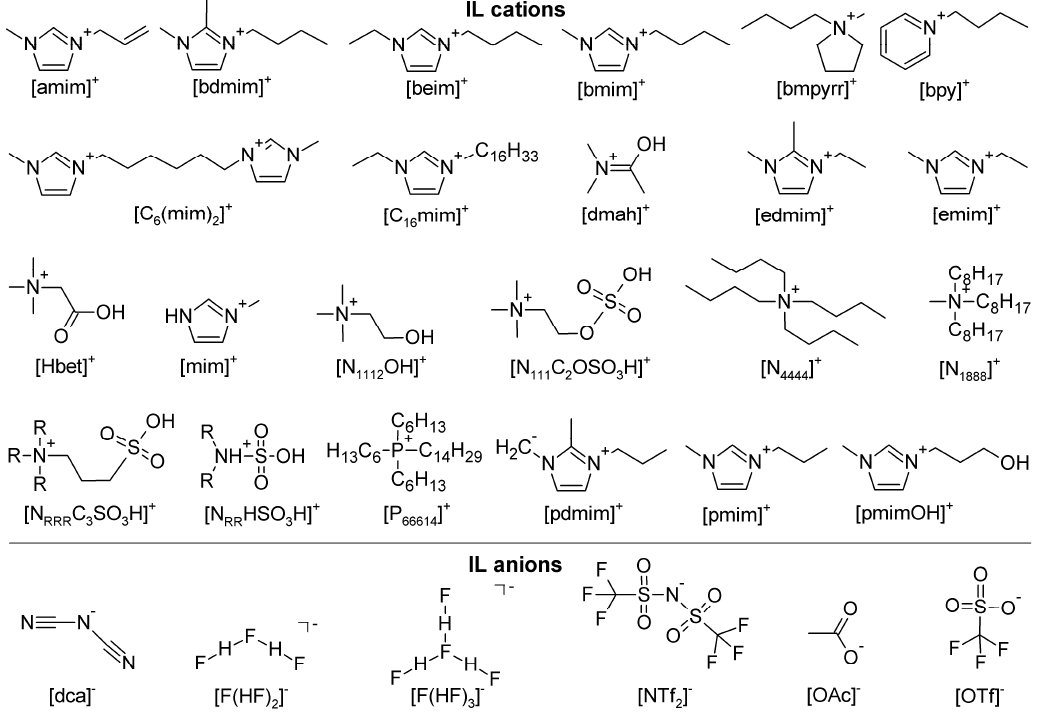
Figure 1. Structures of IL cations and anions addressed in this review.